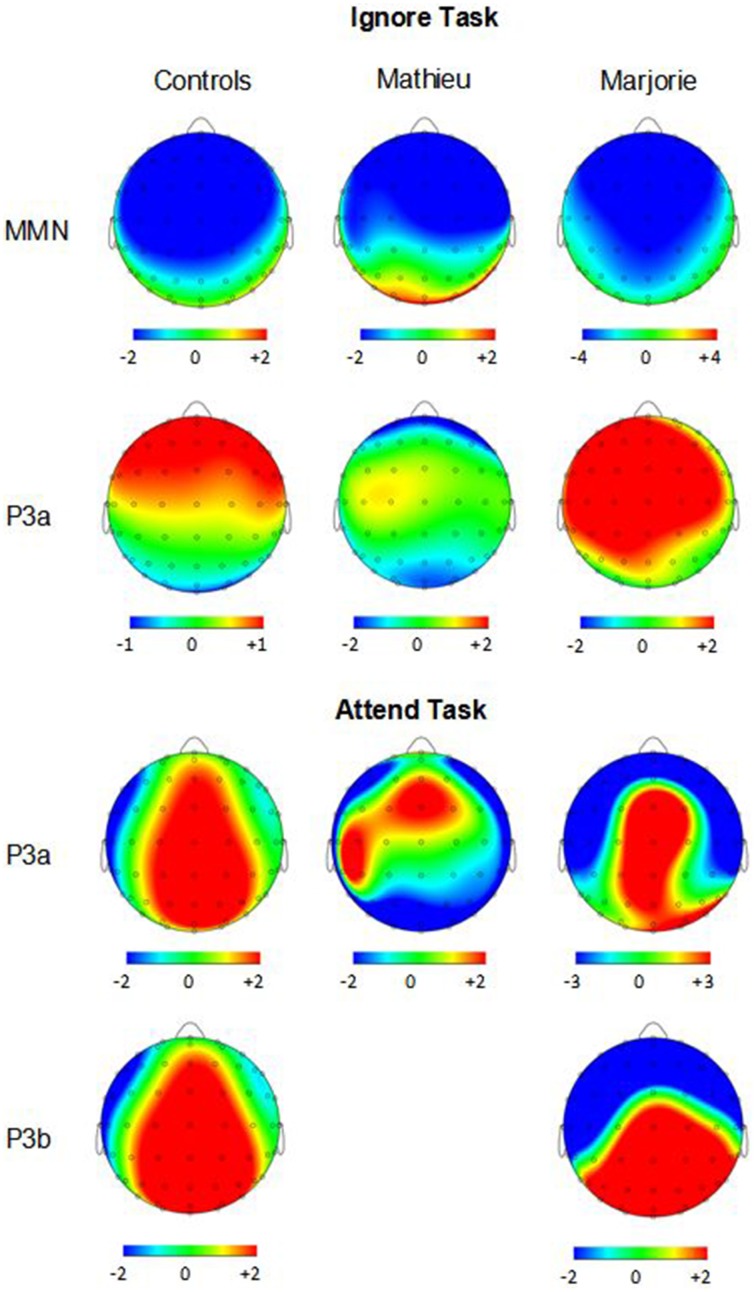
Ignore task and attend task scalp topographies. Voltage (in μV) scalp topographies showing the distribution of the difference between deviant beat omissions and corresponding standard target beats for the MMN and P3a elicited in the ignore task (top two rows) and the P3a and P3b elicited in the attend task (bottom two rows). Activity averaged across the 40 ms surrounding each component's grand-averaged peak is shown. Mathieu's P3b topography is not shown because his mean P3b amplitude could not be distinguished from estimations of noise-based voltage levels.